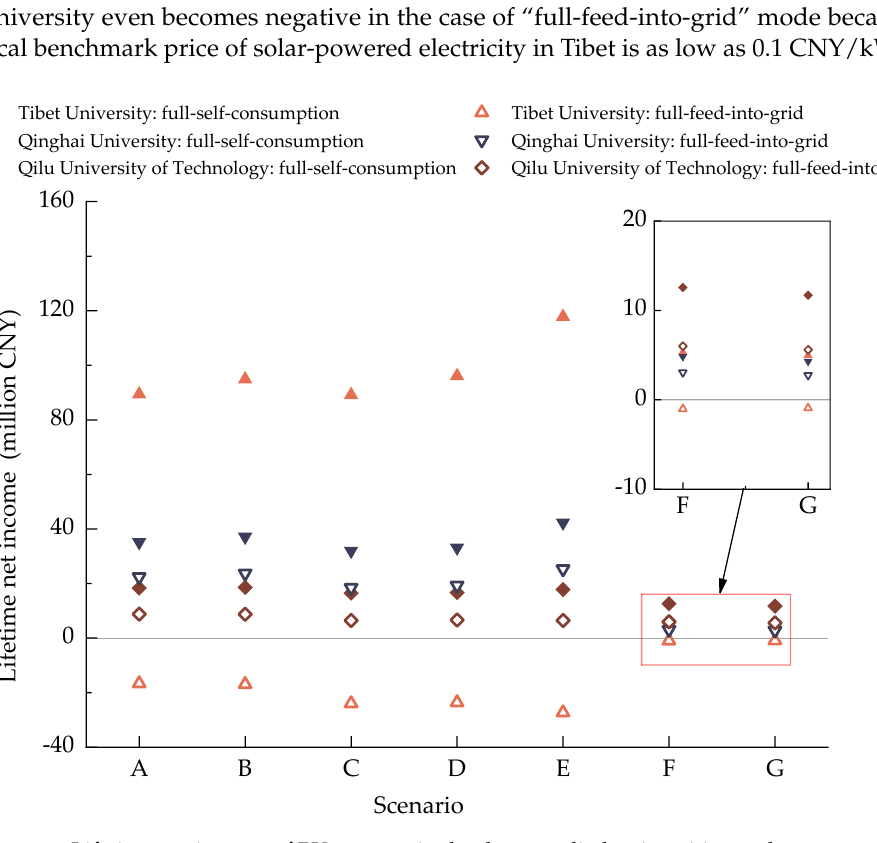
Figure 9. Lifetime net income of PV systems in the three studied universities under seven scenar- ios.